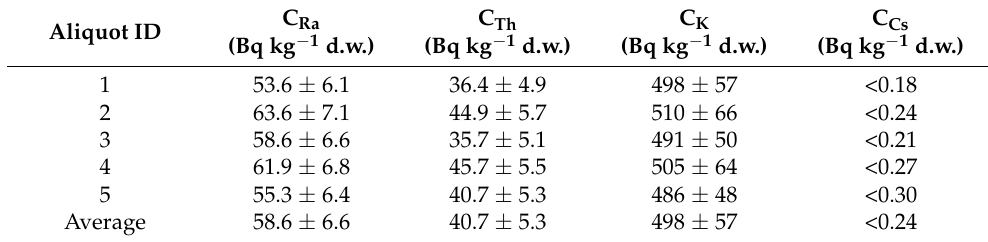
Table 2. The specific activity C Ra, C Th, C K and C Cs of, respectively, 226 Ra, 232 Th, 40 K and 137 Cs, in the five analyzed aliquots, together with the average values. Aliquot